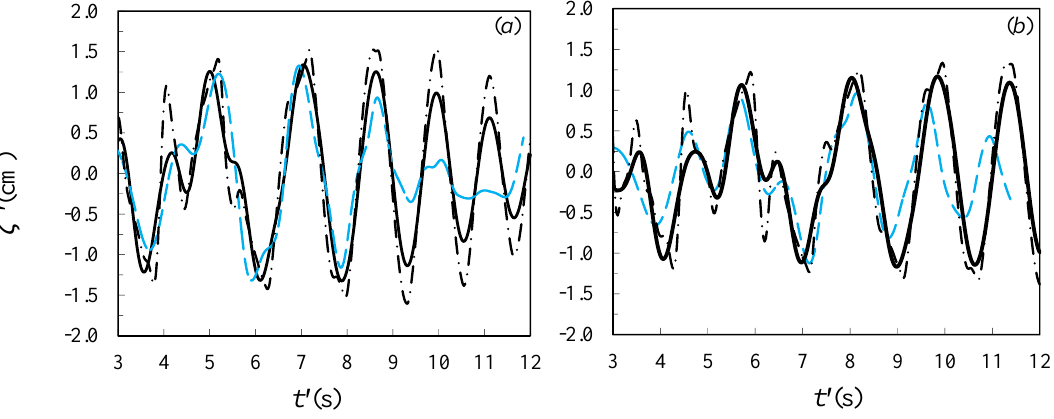
Fig. 5. Free-surface time series at (a) (x 0 ,y 0 ) = ( 0 , 3 . 10 m ) and (b) (x 0 ,y 0 ) = ( 0 , 4 . 07 m ) . The blue dashed line shows the experimental data. The solid line ( − ) represents the theoretical values for the double Gaussian slide, while the dash-dotted line ( −· ) refers to the double parabolic slide. For both scenarios, the free-surface elevation is evaluated with the stationary-phase approximation formula and then transformed into dimensional